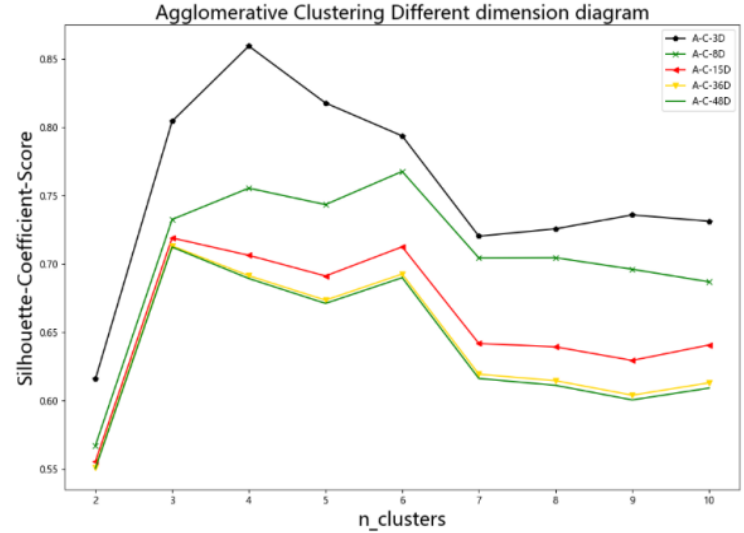
Figure 6. Comparison of clustering effects of different dimensions.